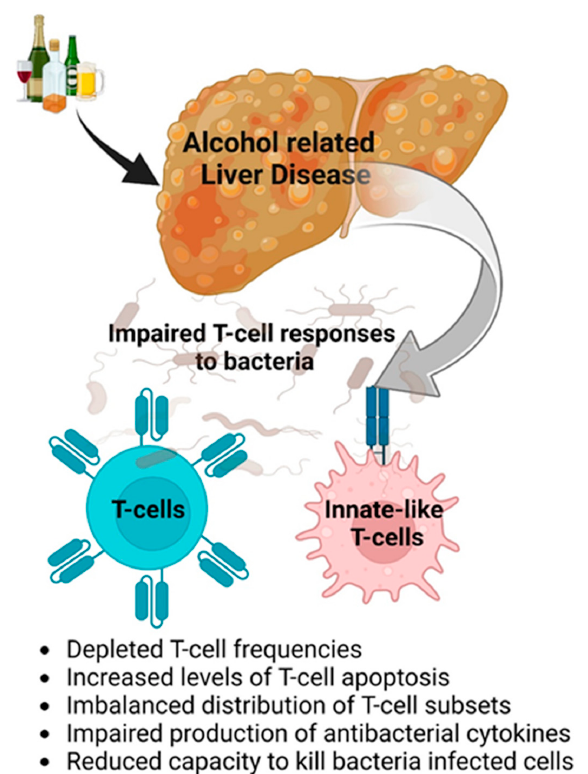
Figure 2. ALD is associated with a dysfunctional T-cell